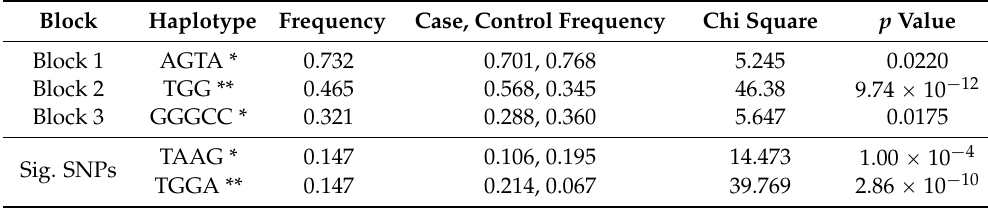
Table 3. Significant haplotypes associated with CAD in Saudi Arabian population. Block Haplotype Frequency Case, Control Frequency Chi